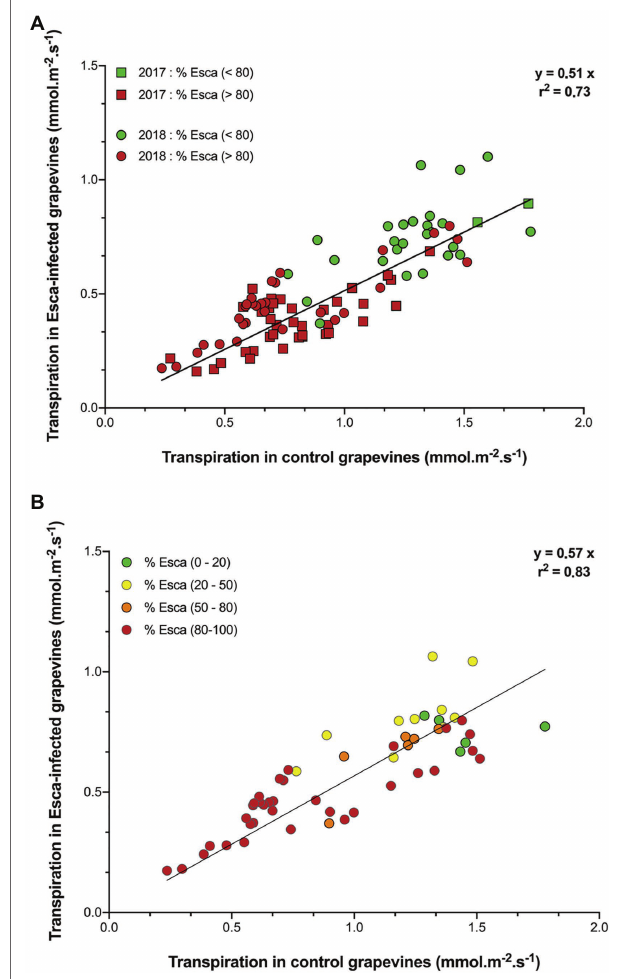
FIGURE 4 | Comparison of transpiration in asymptomatic and symptomatic Cabernet Sauvignon grapevines. Data represent transpiration values under non-limited light conditions, i.e., measured between 10:00 a.m. and 4:00 p.m. In (A) data were separated to reflect days “before” (green symbols) and “after” (red symbols) the prevalence of Esca-foliar symptoms reached 80% in 2017 (squares) and 2018 (circles). In (B) data from 2018 were separated to reflect days with different prevalence levels of Esca symptoms: 0–20% (green symbols), 20–50% (yellow symbols), 50– 80% (orange symbols), and 80–100% (red